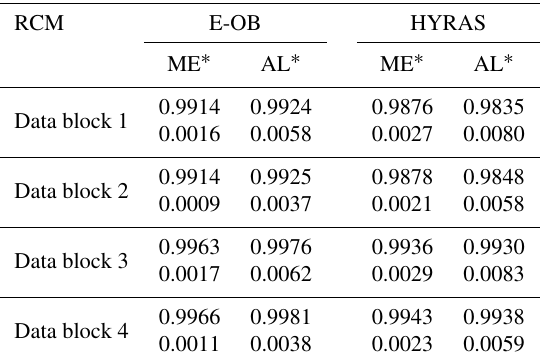
Table 2. Coefficients of determination R 2 (top number) for the quantile–quantile contemplation of Fig. S2 and linear error in prob- ability space L (bottom number) between the RCM and both ob- servations (E-OBS and HYRAS) for Mid-Europe (ME ∗ ) and the Alps (AL ∗ ), always using HYRAS grid cells only. Both quantities are based on daily spatial mean precipitation amounts. RCM E-OB HYRAS ME ∗ AL ∗ ME ∗ AL